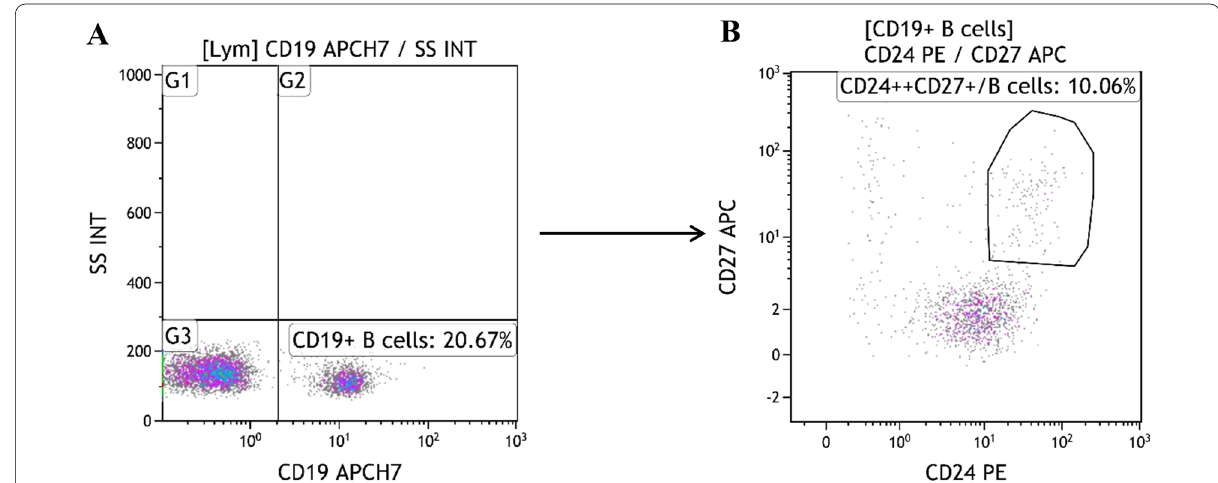
Fig. 1 Gating strategy for B lymphocytes by flow cytometry. A expressed as a single parameter of CD19 and scatter, B expressed as CD24 high CD27 + B